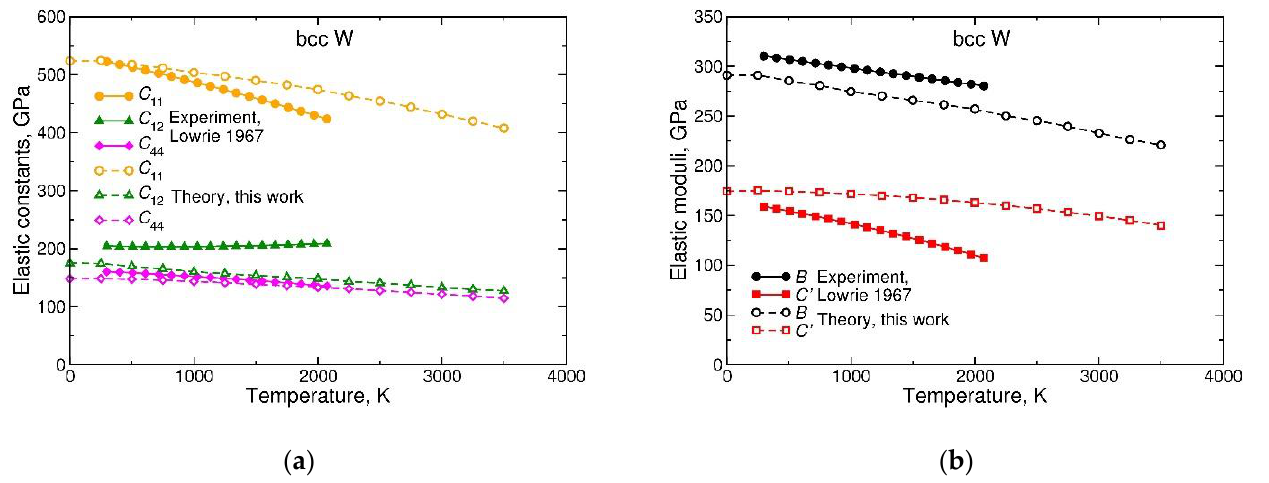
Figure 7. Temperature dependencies of elastic properties of bcc W, derived from the Helmholtz free energy modeled using a quasi-harmonic Debye model (QDM), in comparison with experimental measurements of Reference [63]: ( a ) cubic elastic constants 𝐶 11 , 𝐶 12 , and 𝐶 44 ; ( b ) bulk modulus 𝐵 ≡ 𝐵 𝑇 and tetragonal shear modulus 𝐶 ’. Open symbols with dashed lines are theoretical results and solid symbols with solid lines are experimental data.